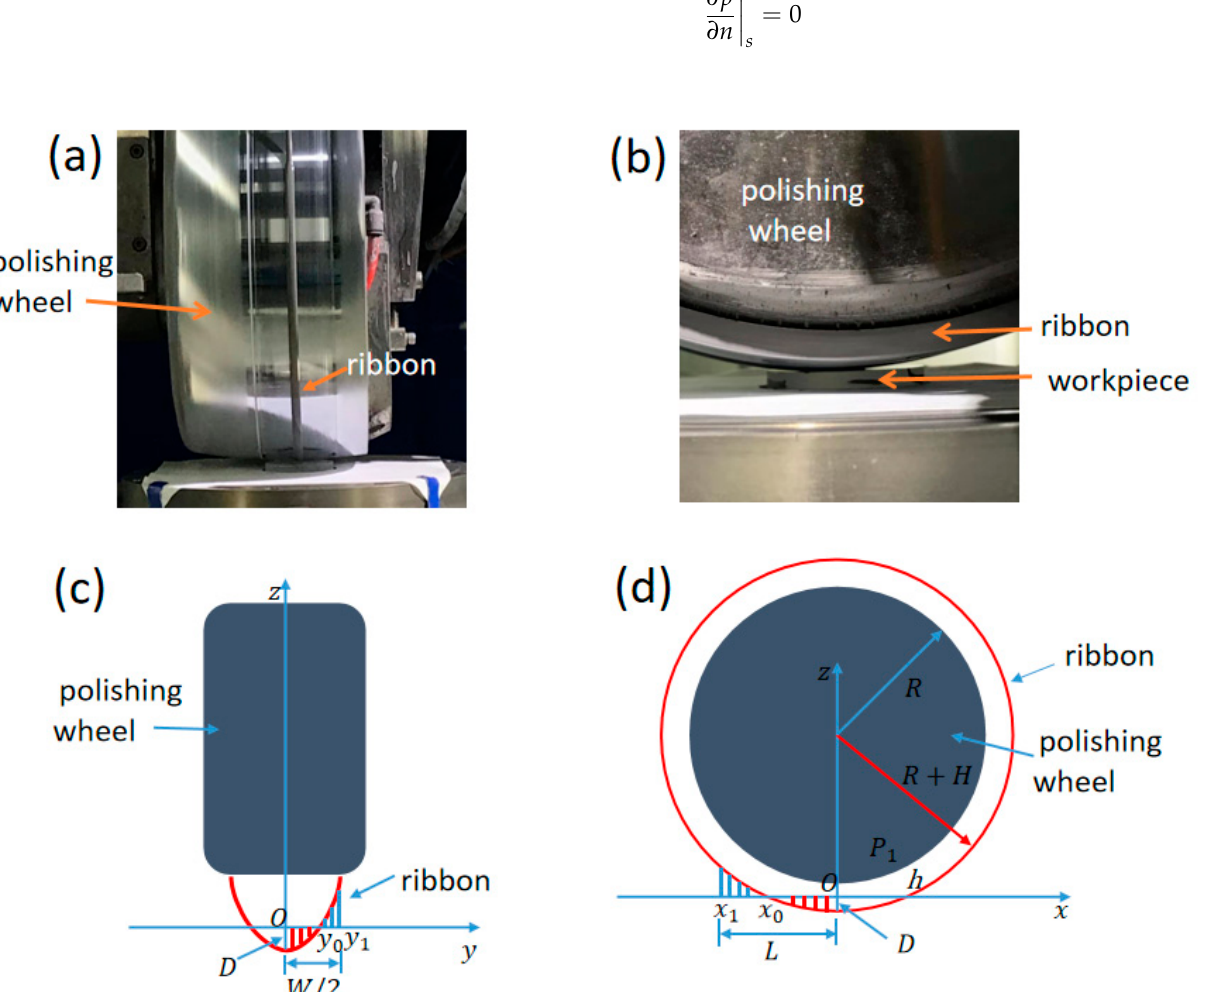
Figure 1. ( a ) MRF fluid ribbon on the polishing wheel, ( b ) contact of the fluid ribbon and the workpiece, ( c ) coordinate system of the polishing wheel and workpiece seen from the x -axis and ( d ) coordinate system of the polishing wheel and the FS work-piece seen from the y -axis.